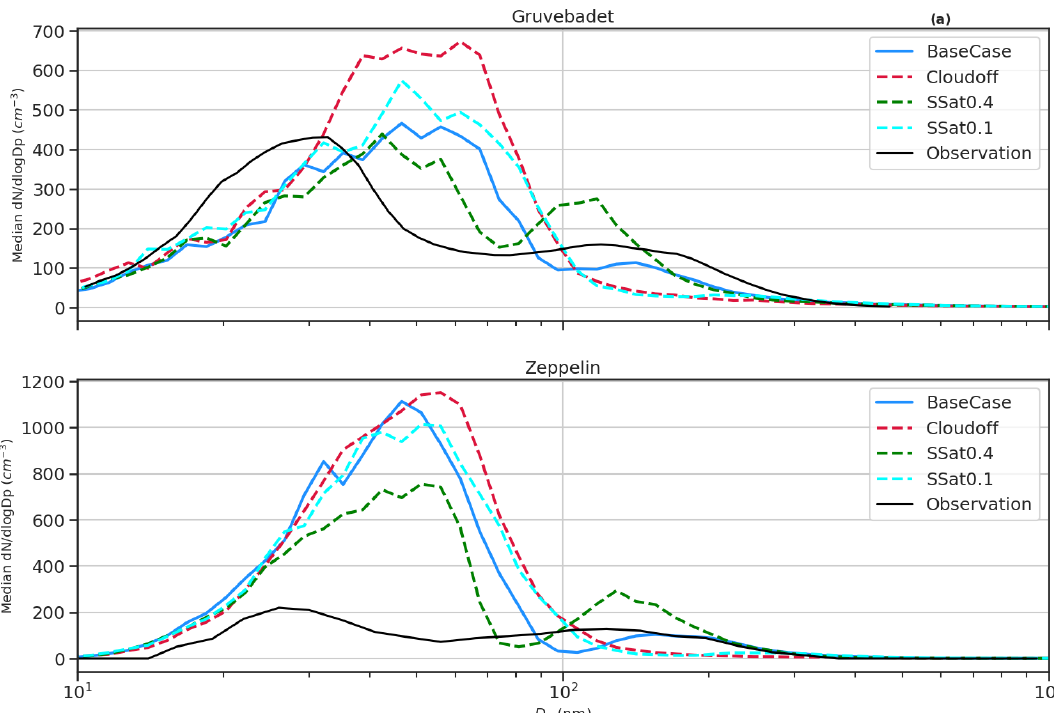
Figure 8. Median size distribution at Gruvebadet (a) and Zeppelin (b) for all the sensitivity tests Cloudoff, S sat = 0 . 4, and S sat = 0 . 1 (colored dashed lines) including BaseCase (blue solid line) and observations (black solid